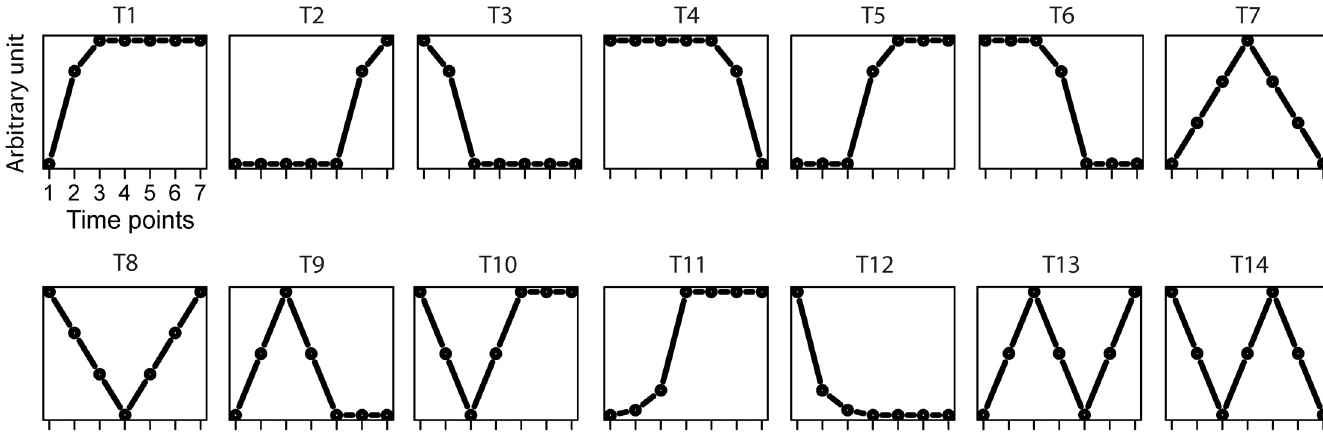
Fig 2. Temporal profile templates used in simulation studies. Fourteen temporal profiles templates, each with seven time points and a unique time- course pattern, were defined for generating simulation datasets. For each time point, a random variable with a defined Gaussian distribution is used to generating the temporal profile for the simulation